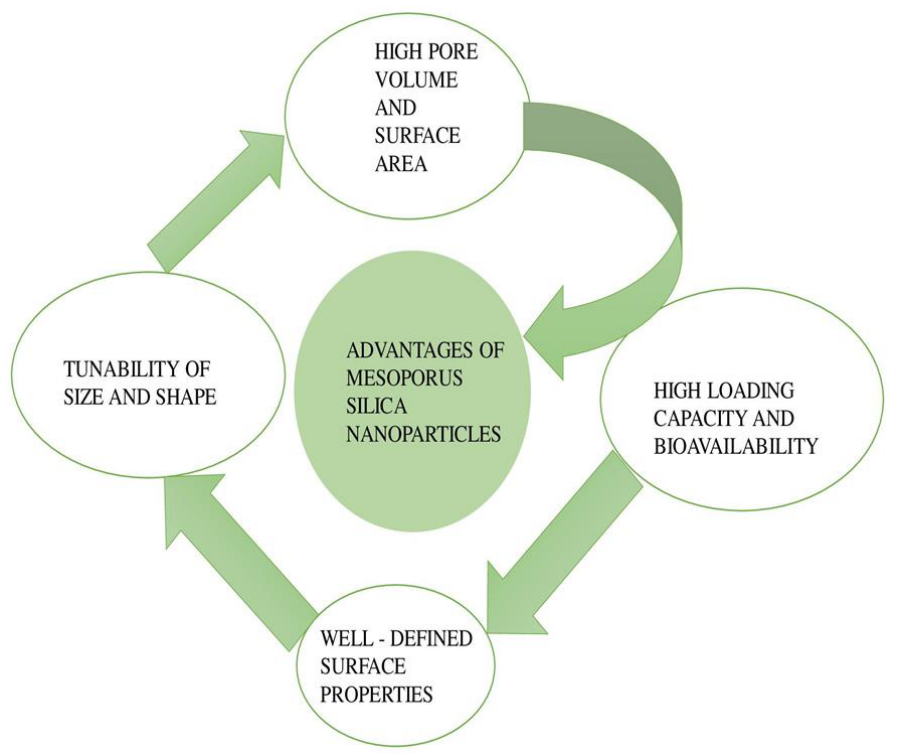
Figure 9. Advantages of mesoporous silica nanoparticles.